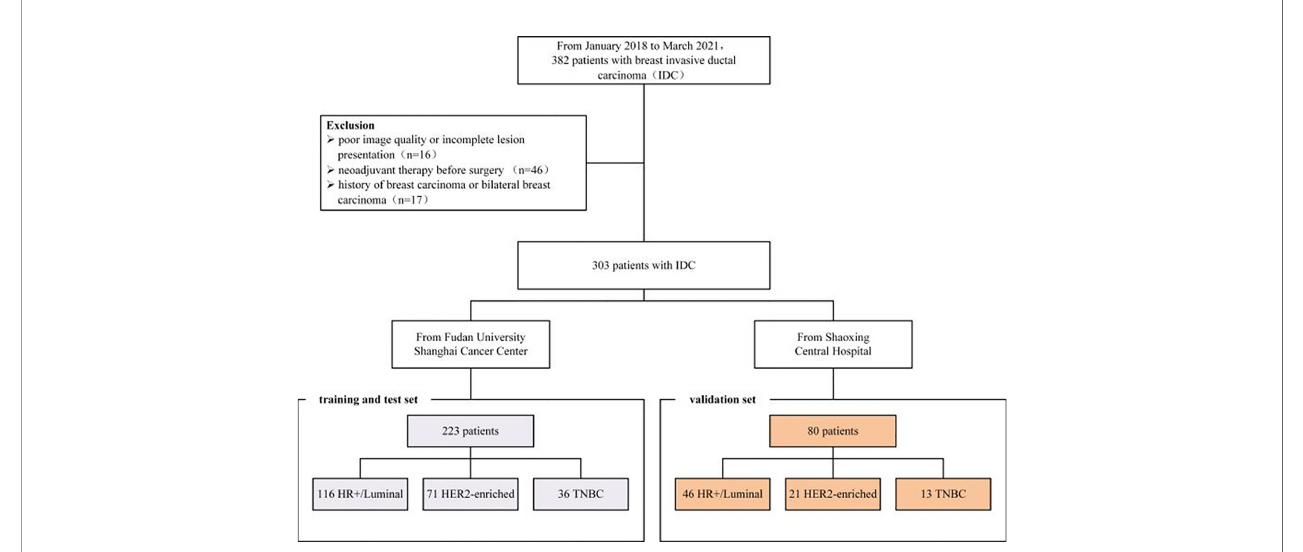
FIGURE 1 | Patient work fl